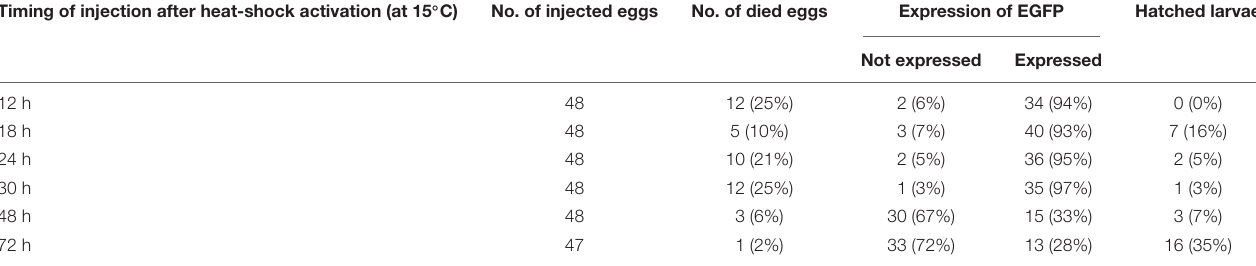
TABLE 3 | Effect of embryonic stage on microinjection efficiency in embryos of parthenogenetic strain B. mori 1–31 incubated at 15 ◦ C. Timing of injection after heat-shock activation (at 15 ◦ C) No. of injected eggs No. of died eggs Expression of EGFP Hatched larvae